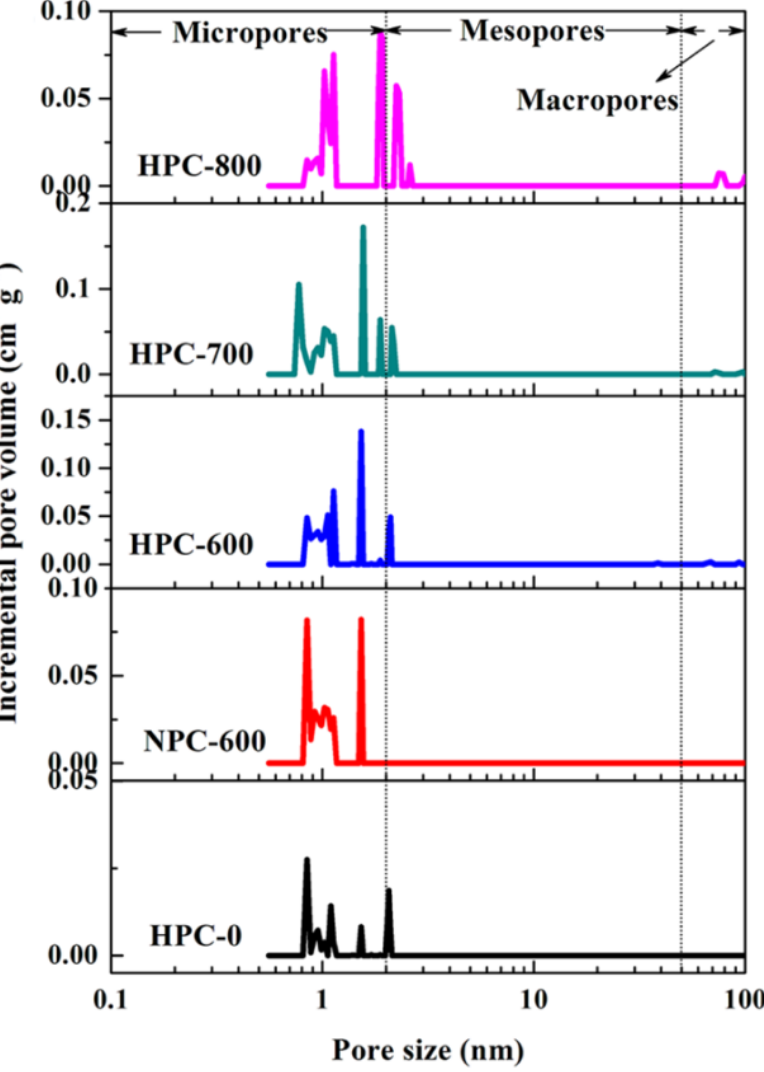
Figure 40. PSDs obtained from DFT method of all samples (reproduced from the work in [93] with permission).